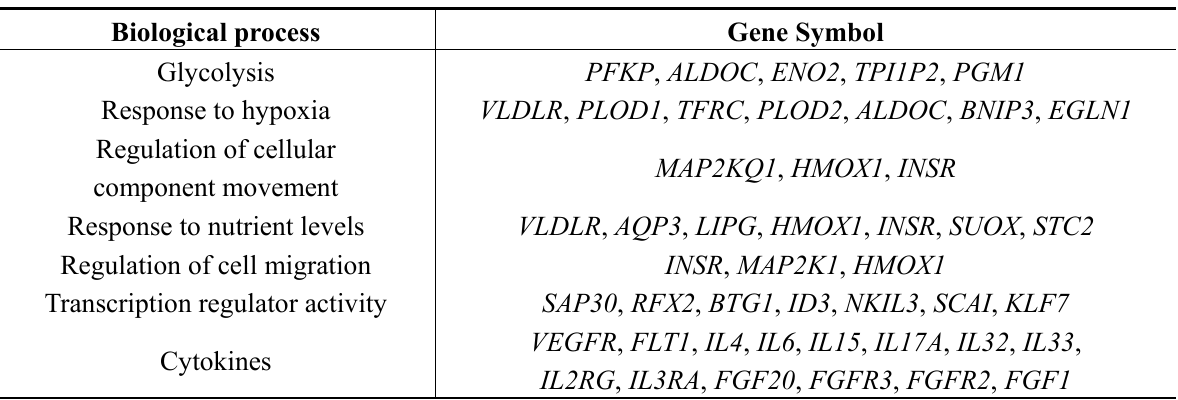
Table 1. The significantly regulated genes classfied according to their function under hypoxia